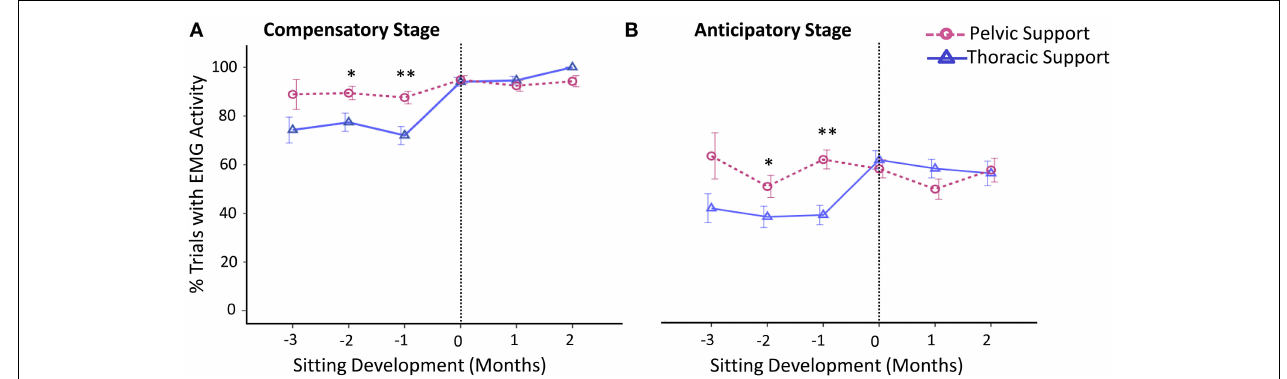
FIGURE 5 | Estimated means of group data across sitting developmental time. Y-axis displays percentage of trials with EMG activity during the (A) compensatory postural adjustment stage and (B) anticipatory postural adjustment stage. X-axis displays